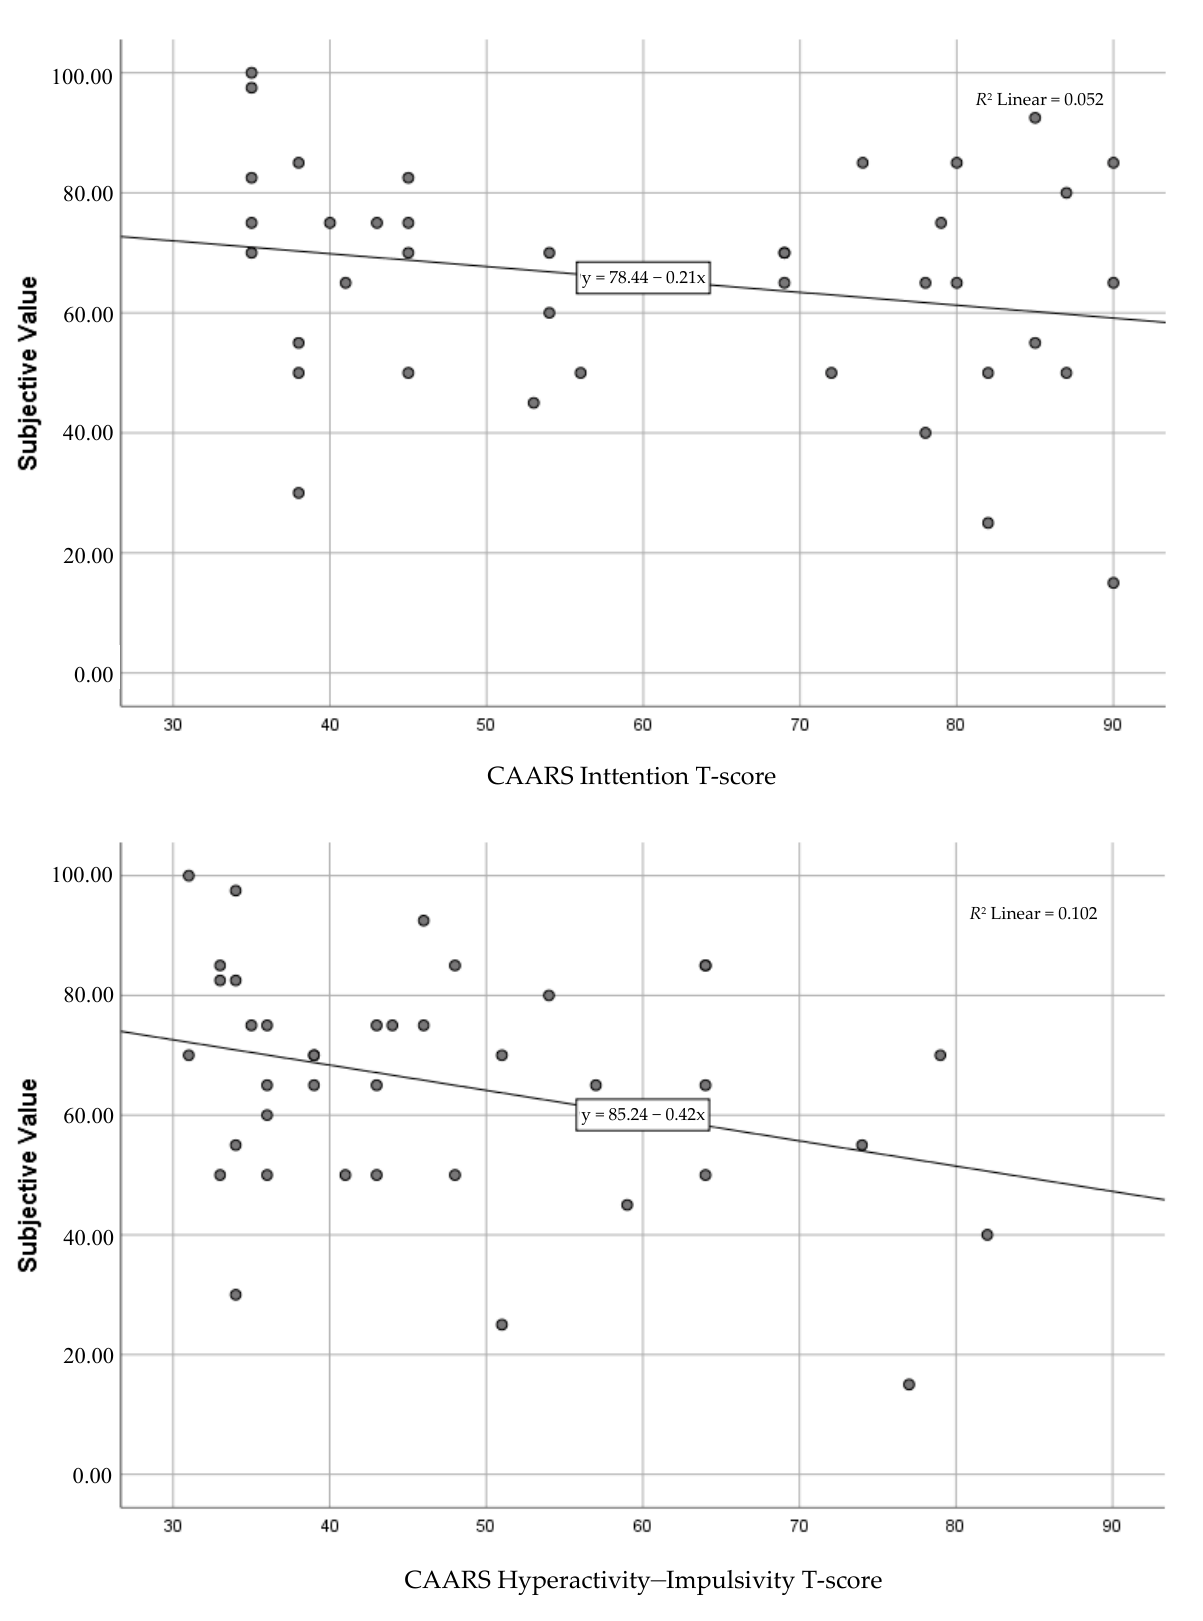
Figure 1. Associations between Inattention and the subjective value of € 100 after 1 year ( top panel ) and Hyperactivity– Impulsivity and subje ctive value of €100 after 1 year ( bottom panel ). Table 3. Regression analyses with Inattention, Hyperactivity–Impulsivity, BDEFS EF total, and